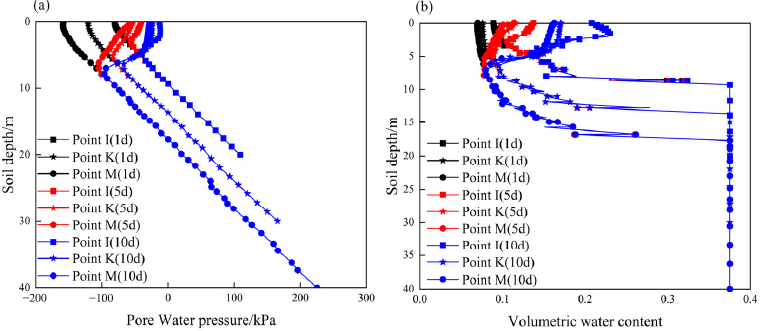
Figure 15. Distribution curves of pore water pressure and volumetric water content with depth of the protected slope after rainfall: ( a ) pore water pressure; ( b ) volumetric water content.